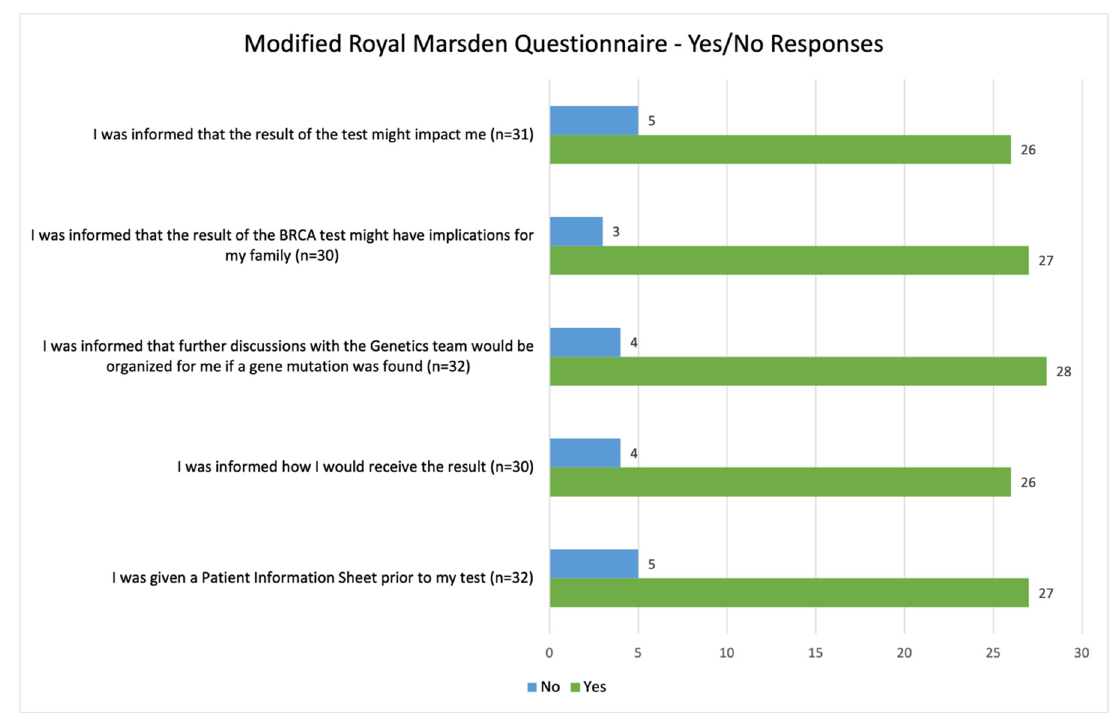
Figure 4. Summary of patient responses to the yes or no questions from the modified Royal Marsden Patient Satisfaction questionnaire.